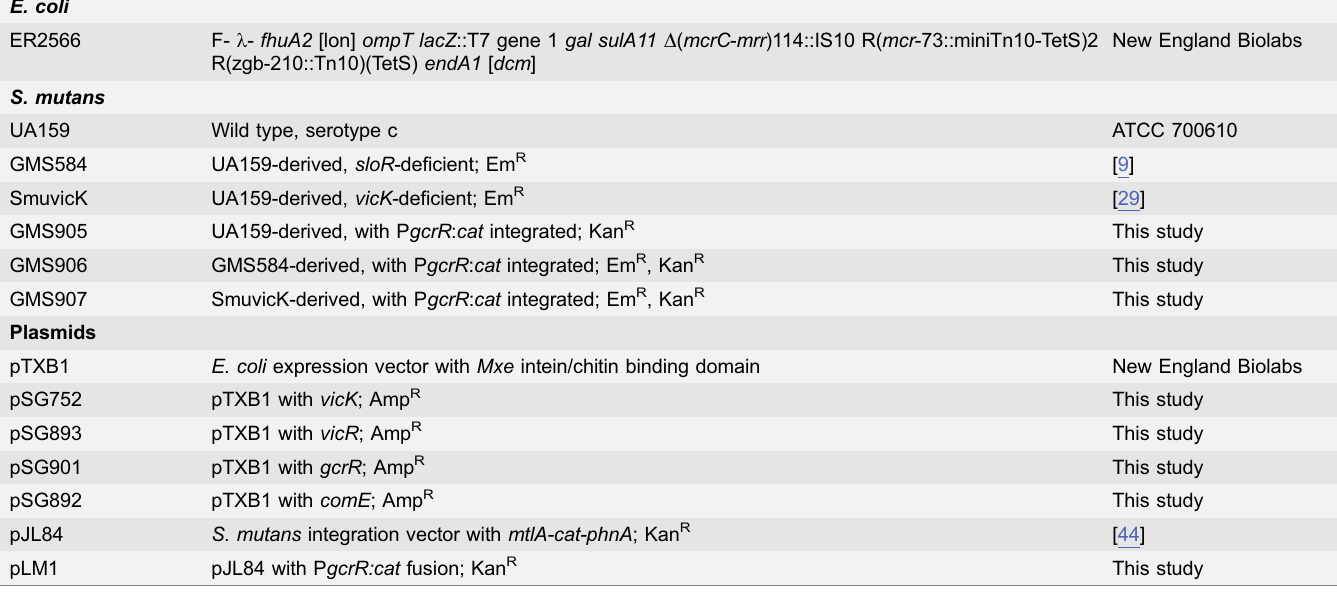
Table 1. Bacterial strains and plasmids used in this